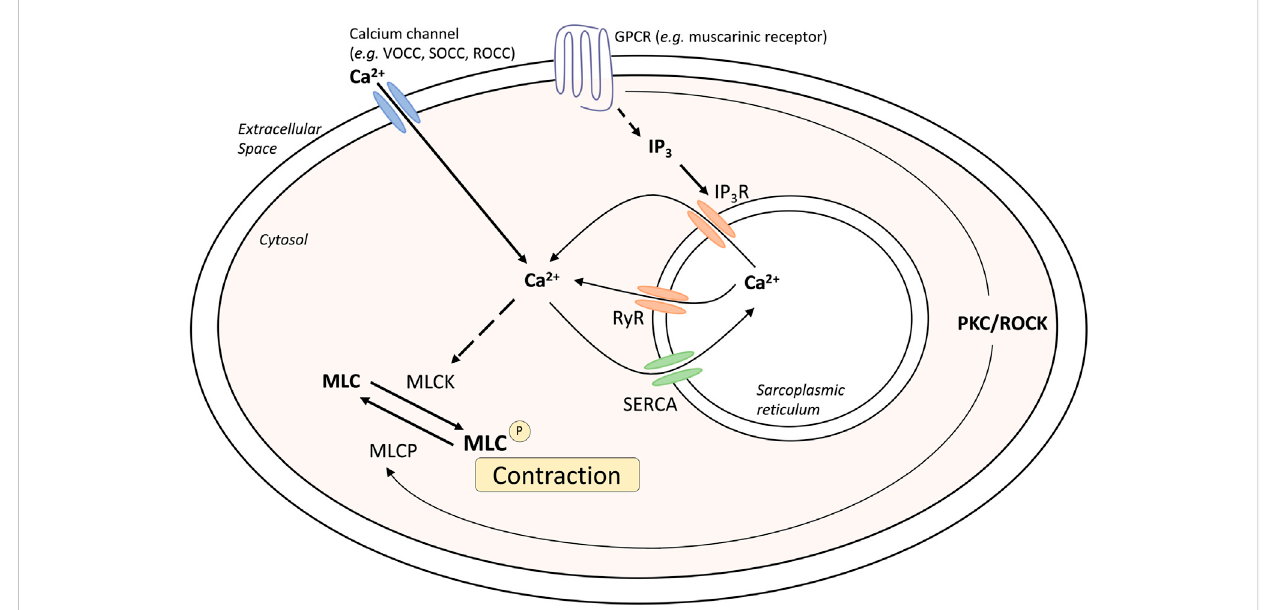
FIGURE 1 Mechanisms of airway smooth muscle contraction. Abbreviations: IP3, inositol triphosphate; GPCR, G-protein coupled receptor; MLC, myosin light chain;MLCK,myosinlightchainkinase;MLCP,myosinlightchainphosphatase;PKC,ProteinkinaseC;ROCC,receptoroperatedcalciumchannel;ROCK, Rho associated coiled-coil containing protein kinase; RyR, Ryanodine receptor; SERCA, Sarco/endoplasmic reticulum Ca(2 + )-ATPase; SOCC, storage operated calcium channel; VOCC, voltage operated calcium